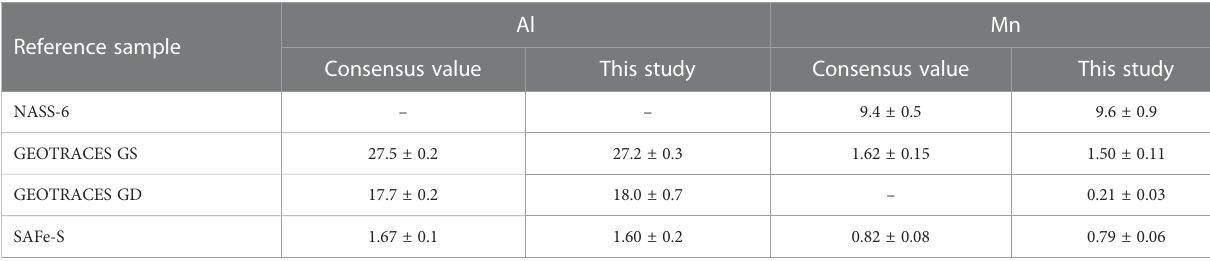
TABLE 1 Comparison of measured dAl (nM) and dMn (nM) concentrations (this study) and consensus values in SAFe and GEOTRACES reference samples (n = 3).